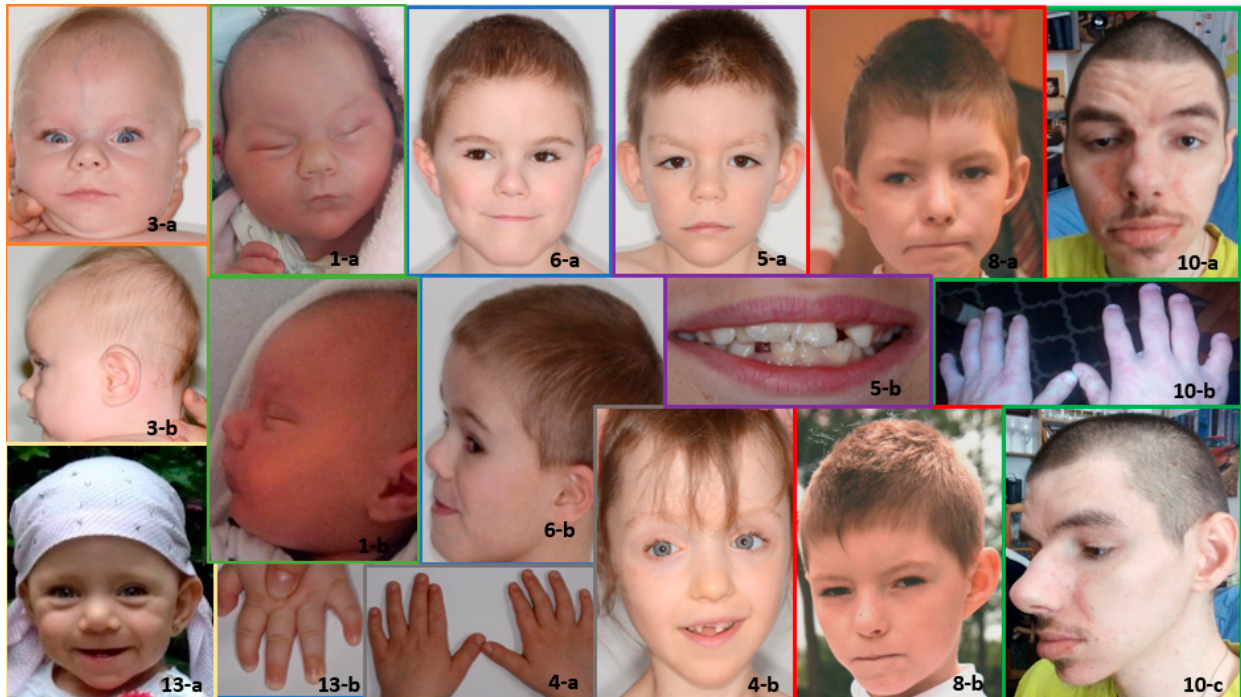
Figure 1. Dysmorphic features in a subset of patients with KBG syndrome. Note the wide and triangular face shape (in all patients) and pear ‐ shaped skull (Patient 1 ‐ a and 8 ‐ a), narrow (Patient 6 ‐ a and 8 ‐ a) and elongated palpebral fissures (Patient 1 ‐ a, 4 ‐ b, 5 ‐ a and 8 ‐ a ), short nose with broad tip (Patient 1 ‐ a, 3 ‐ a, 5 ‐ a and 6 ‐ a), narrow upper lip (Patient 4 ‐ b, 5 ‐ a, 6 ‐ a, 8 ‐ a, and 13 ‐ a), brachydactyly (Patient 10 ‐ b and 13 ‐ b) and clinodactyly of the fifth digit (Patient 4 ‐ a, 10 ‐ b and 13 ‐ b). The phenotype changes with age—the cases presented here are from ages 4 months (Patient 1 and 3) to 26 years (Patient 10). The oldest patient has small palpebral fissures, unilateral ptosis, a big nose, a thick lower lip and marked interphalangeal joints (Patient 10 ‐ a ‐ c).